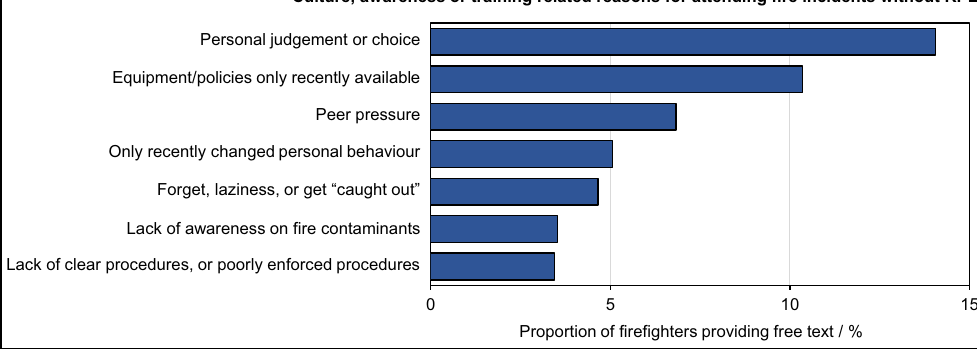
Figure 3. Culture, awareness and training and attending fires without RPE . Cultural/awareness related reasons for firefighters’ attending fire incidents without respiratory protective equipment, coded from free text. Note that a single firefighter’s free-text answer may have contained several sentiments belonging to several different themes.